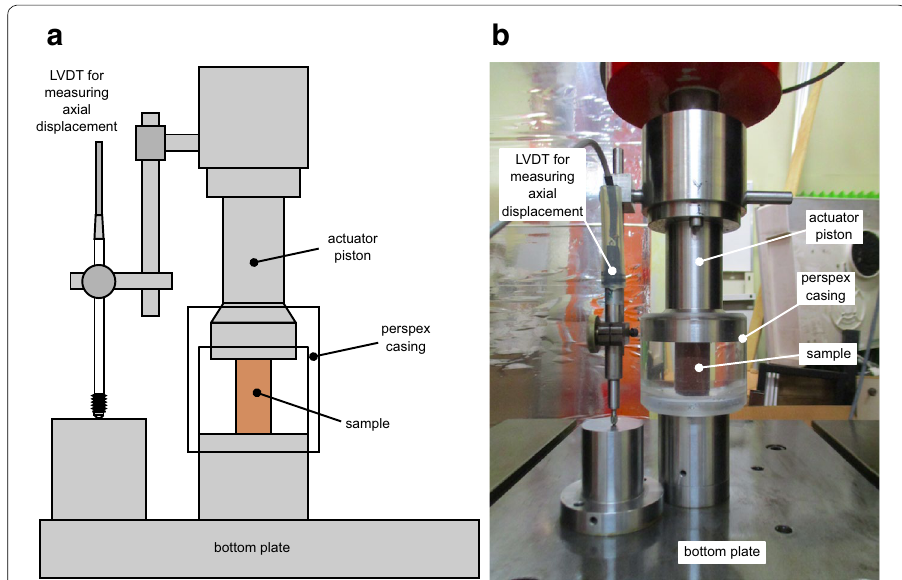
Fig. 4 a Schematic diagram showing the uniaxial compression apparatus used in the study (modified from Heap et al. 2014). b Photograph of the uniaxial compression apparatus used in the study (showing a sample of 540 deformed under water-saturated conditions). For the water- and brine-saturated experiments, the perspex casing is filled with deionised water and hydrothermal brine,